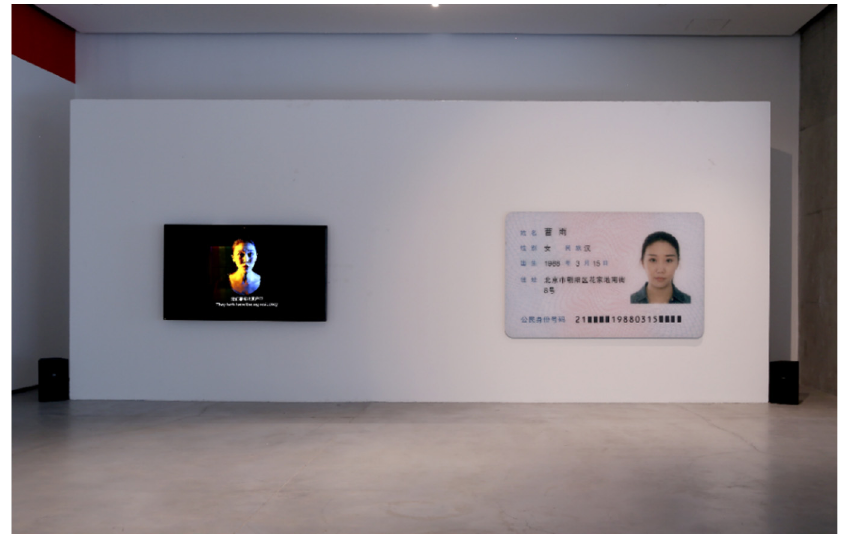
Figure 3 . Yu Cao’s works “I have…” ( Left ) and “Female Artist” ( Right ) in “The 2018 Annual Exhi- bition of Contemporary Chinese Art”, Beijing Minsheng Art Museum. Picture from the Center for Visual Studies, Peking University.